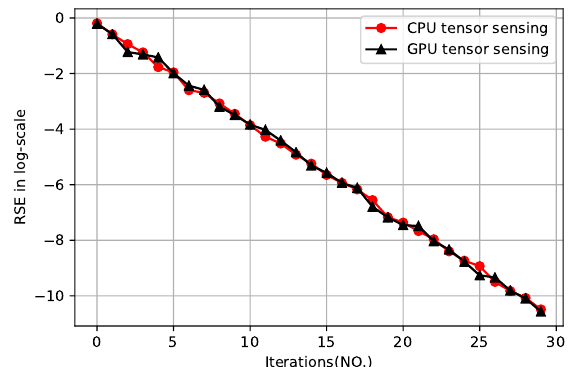
Figure 7. RSE of the CPU tensor sensing and GPU tensor